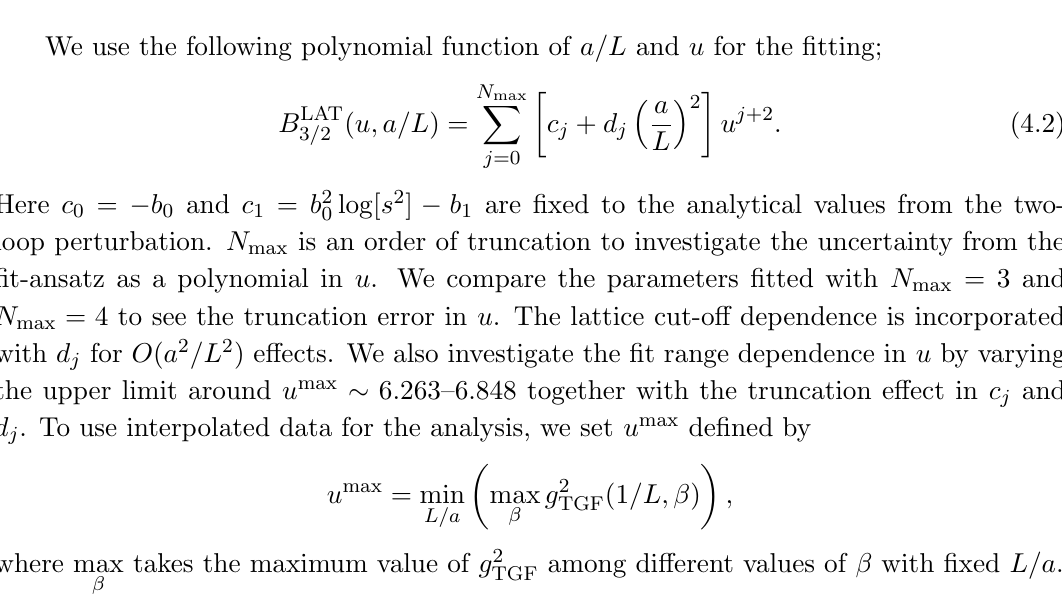
Table 1 . (cont’d) TGF coupling on each L=a and (cid:12)